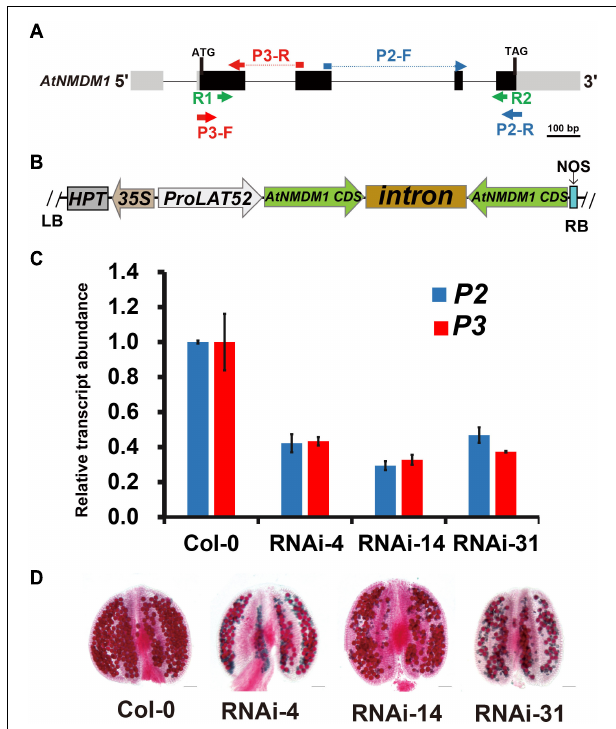
FIGURE 3 | Knockdown of AtNMDM1 expression in Arabidopsis pollen resulted in defective fertility. (A) The genomic structure of AtNMDM1 from Arabidopsis. Exons are represented by black boxes with the size in base pairs of each exon indicated. The primers, R1/R2 of AtNMDM1 RNAi fragments are indicated by green arrows. The primers, P3-F/R (red arrow) and P2-F/R (blue arrow) of two different cDNA fragments in AtNMDM1 are indicated, respectively. (B) The ProLAT52:AtNMDM1- RNAi construct is represented, which is driven by the Tomato pollen-specific promoter, LAT52 . RB, right border; LB, left border; HPT, hygromycin phosphotransferase gene; NOS, nopaline synthase terminator. (C) The transcript levels of AtNMDM1 cDNA fragments are significantly reduced in the anther of three AtNMDM1 RNAi lines RNAi-4, RNAi-14, and RNAi-31. P2 and P3 are two AtNMDM1 cDNA fragments that are designed for the detection of AtNMDM1 expression levels. The location information of P2 and P3 is indicated in (A) . Mean result from three biological replicates are shown. Data were normalized to EF1 α expression. The error bar is the mean ± SE of triplicate experiments. (D) Alexander staining of anthers in AtNMDM1 RNAi lines RNAi-4, RNAi-14, and RNAi-31. Bar = 50 µ